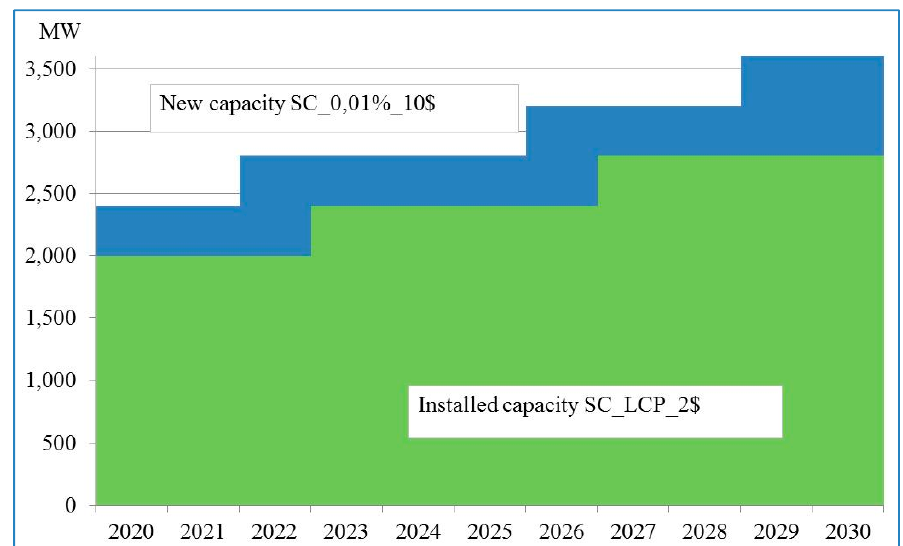
Figure 17. Scenario with VOLL $10 USD/kWh and LOLP = 0.01% versus the scenario with VOLL = $2 USD/kWh and LCP.